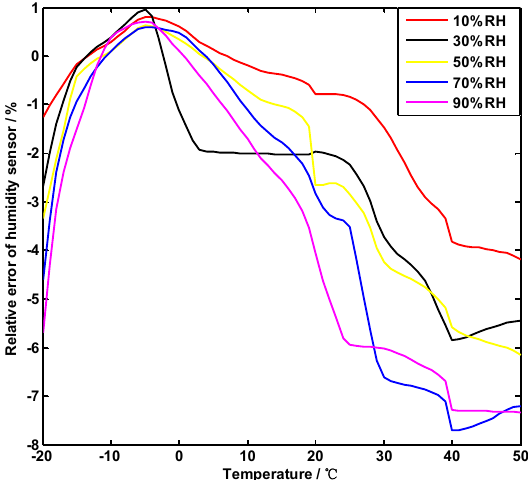
Figure 2. Measured error curve of the humidity sensor at different temperatures.